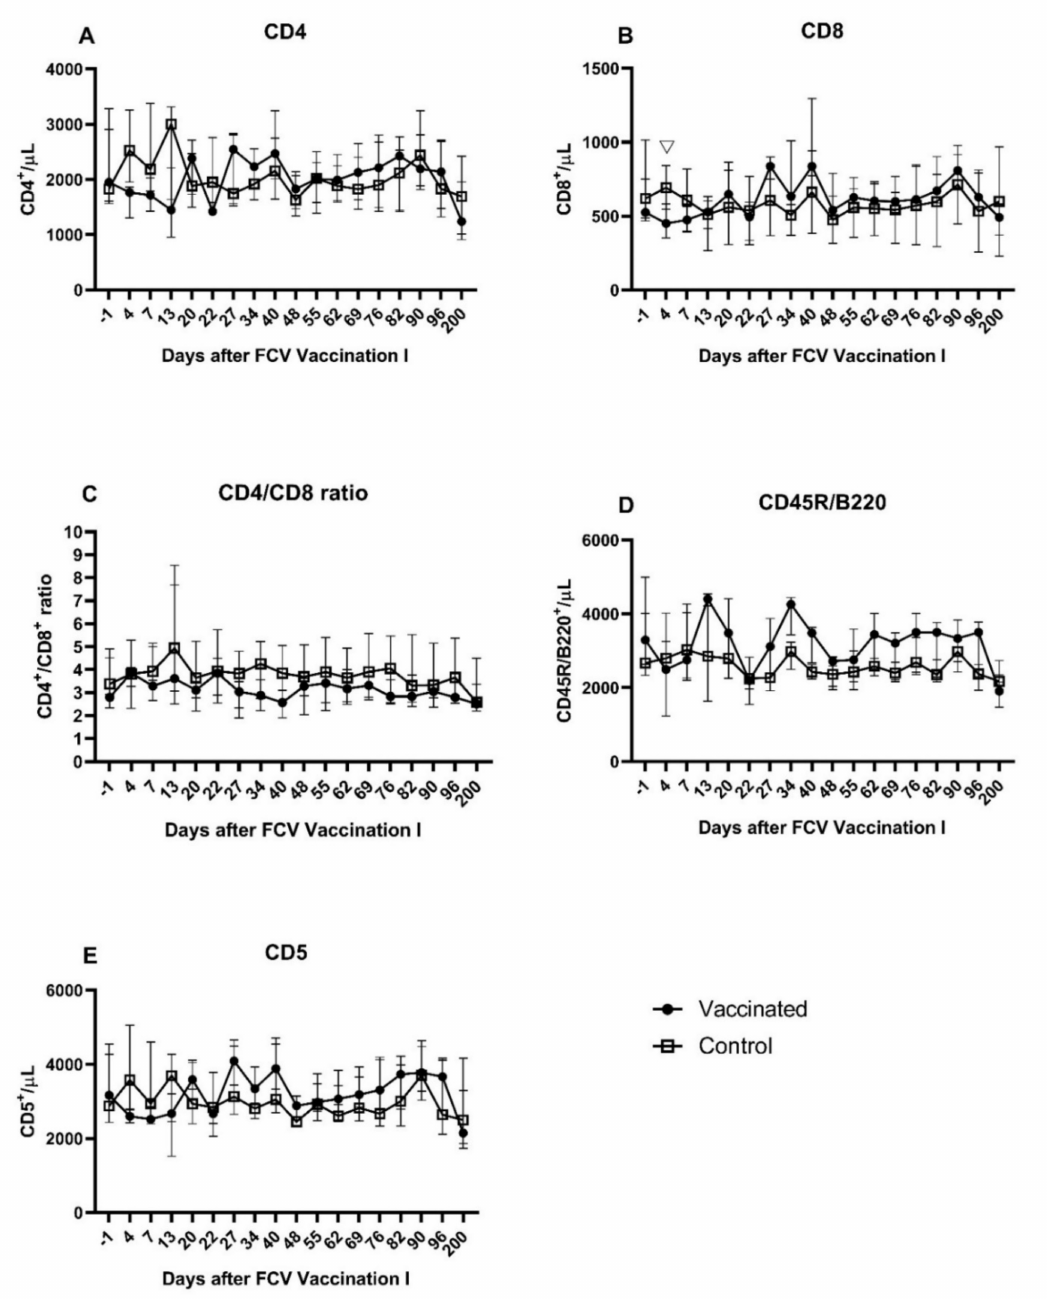
Figure 4. Lymphocyte subsets after FCV Vaccination I. Median ( ± IQR) absolute cell counts of CD4 + ( A ), CD8 + ( B ), CD4 + /CD8 + ratio ( C ), CD45R/B220 + ( D ), and CD5 + ( E ) lymphocytes. Statistically significant differences between the vaccine and the control group are indicated with an open triangle; (cid:53) denotes significantly lower in the vaccine group P MWU ≤ 0.05. The second injection of FCV Vaccination I was performed at day